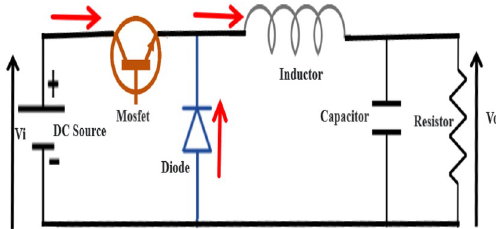
Figure 4. Schematic diagram of Buck